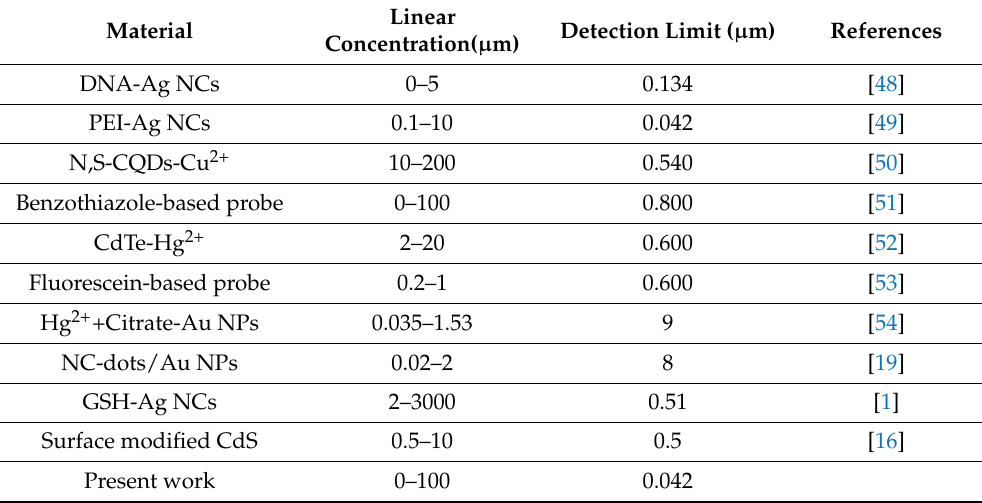
Figure 7. The change in the fluorescence response of MPTMS@Gd 2 O 3 NPs as a function of ( a ) pH and ( b ) increasing concentration of Cys and ( c ) along with the corresponding linear plot between fluorescence intensity of developed nanoparticles in the presence of different concentrations of Cys. Table 1. Comparison of the linear range and detection limit of the proposed sensor with other reported methods for the detection of Cys.